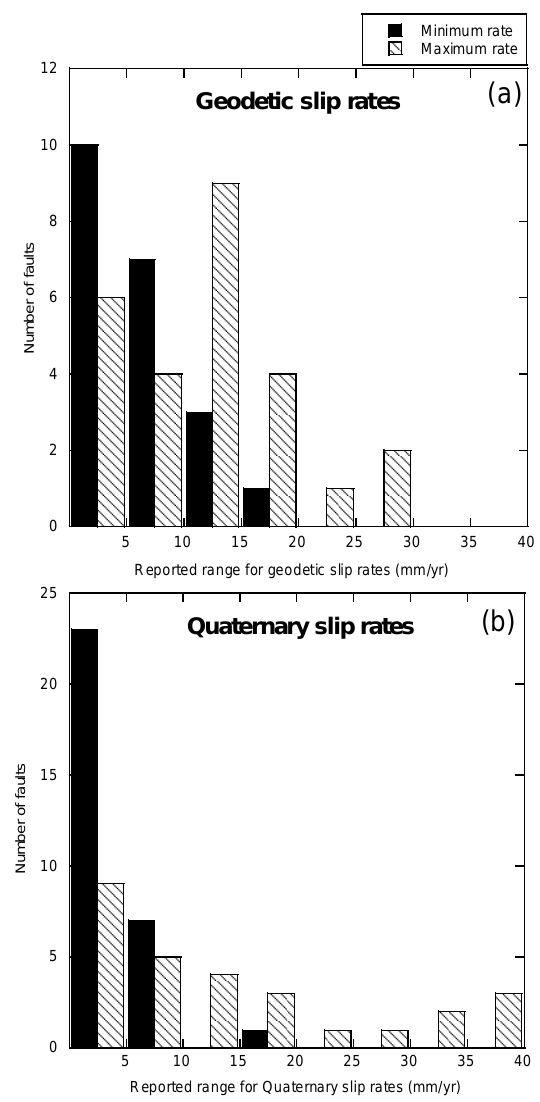
Figure 2. Distribution of geodetic (a) and geologic (b) slip rates as reported in the